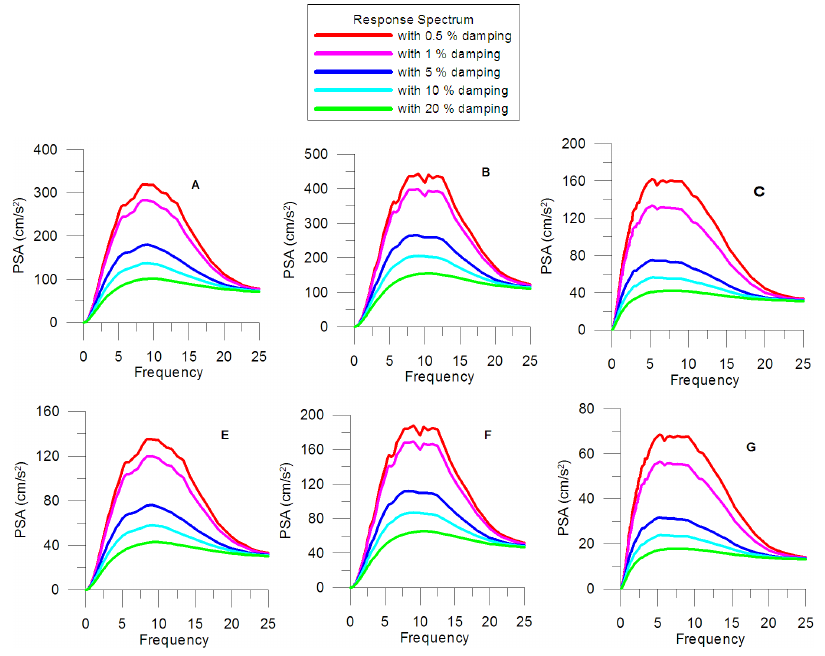
Fig. 11. Panels A , B , and C are the PSA predicted from the seismogenic zones 1, 2, and 3 at the high amplification site (site 2), respectively. Panels E , F , and G are the PSA predicted from the seismogenic zones 1, 2, and 3 at the low amplification site (site